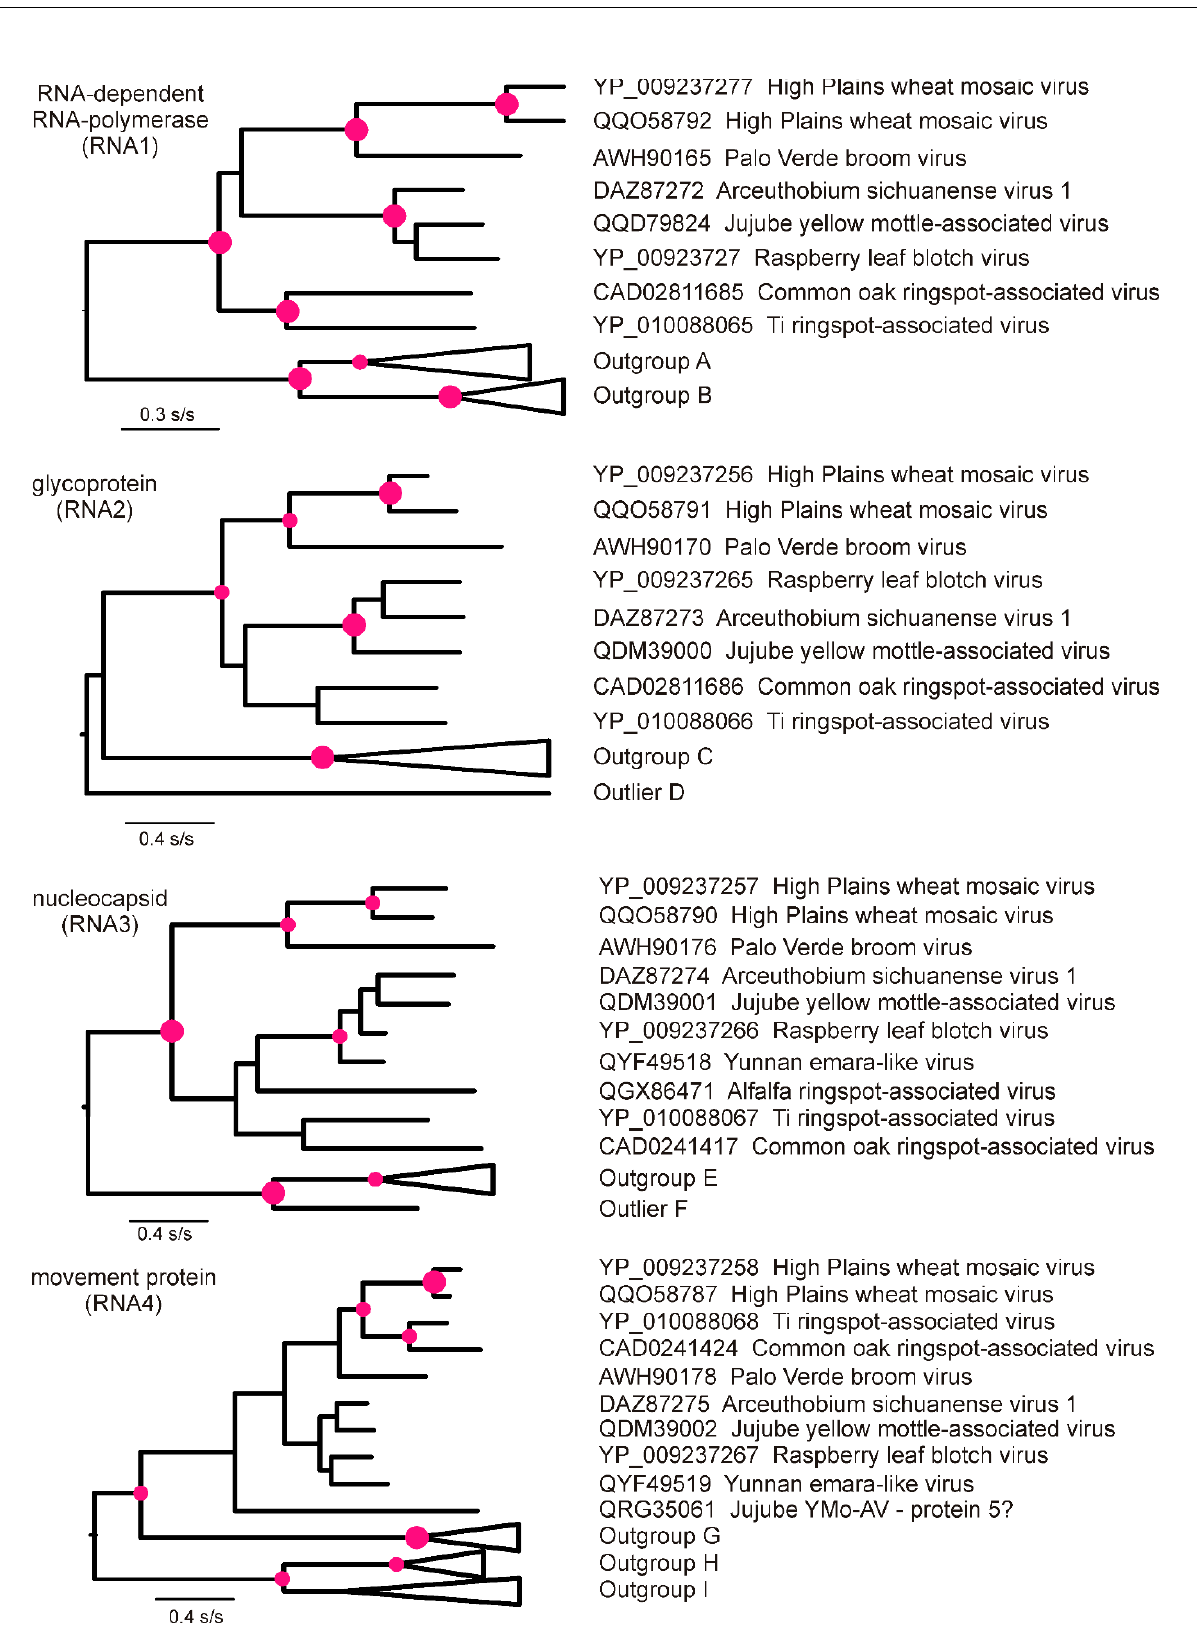
Figure 3. Phylogenies calculated from the amino acid sequences of the RNA-dependent RNA polymerase, glycoprotein, nucleocapsid, and movement proteins of four isolates of HPWMoV (only lineages 1 and 2 shown) and representatives of the closest proteins identified by a BLASTX search of Genbank—for details, see the text.